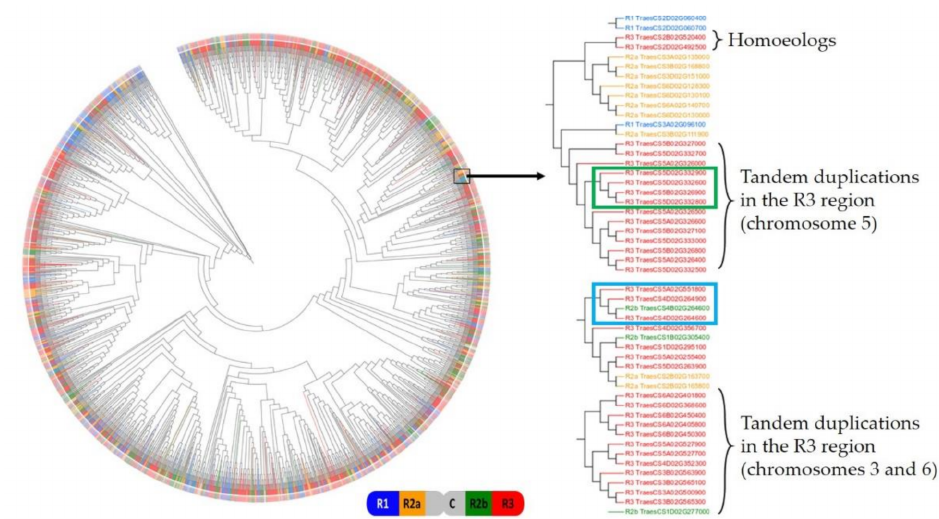
Figure 6. Phylogenetic tree of the 3565 TaFBX mapped on the wheat pseudomolecule. The tree was built using alignment of protein sequences. Using iTOL, each branch of this tree was annotated and colored according to the chromosomal region the gene originated from (blue for R1, orange for R2a, grey for C, green for R2b and red for R3). The branch length was not proportional to the parental degree. The right panel presents a zoom on a particular clade of the phylogenetic tree, where two specific clades are framed by a green or a blue